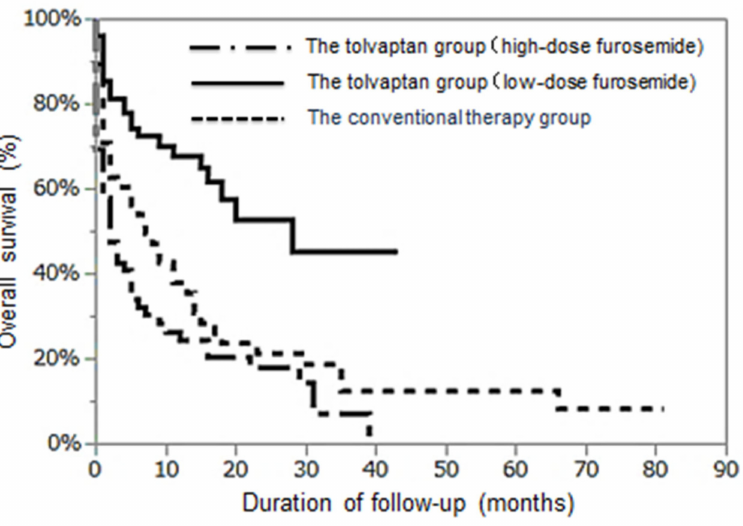
Figure 4. Comparison of cumulative survival rates among the conventional therapy group and the tolvaptan groups with low- or high-dose